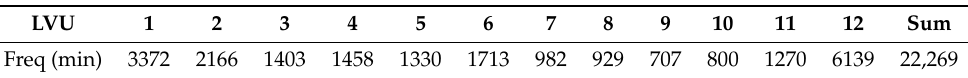
Table 2. LVU frequencies in